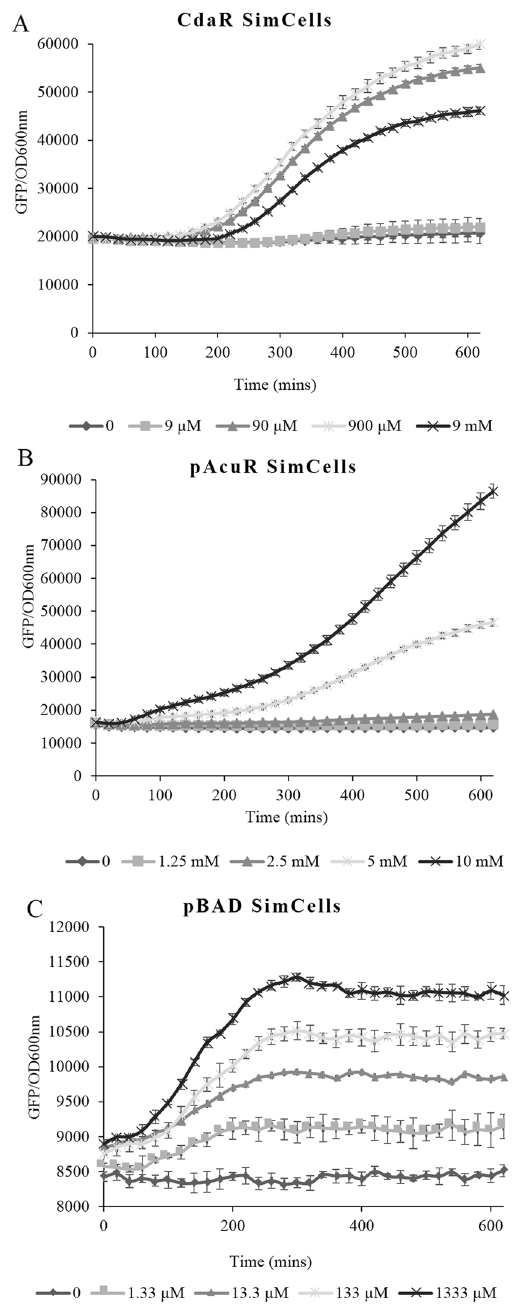
Figure 3. Induction of purified SimCells in PBS over time, as determined by GFP fluorescence per unit OD at 600 nm (n = 4). Error bars denote one standard deviation above and below the mean. ( A ) pCdaR SimCells induced by glucarate (significant induction relative to the control (p < 0.05) at 90 µ M glucarate and above). ( B ) pAcuR SimCells induced by acrylate (significant induction at 5 mM acrylate and above). ( C ) pBAD SimCells induced by arabinose (significant induction at all concentrations tested). The OD 600 nm curves are shown in Fig.